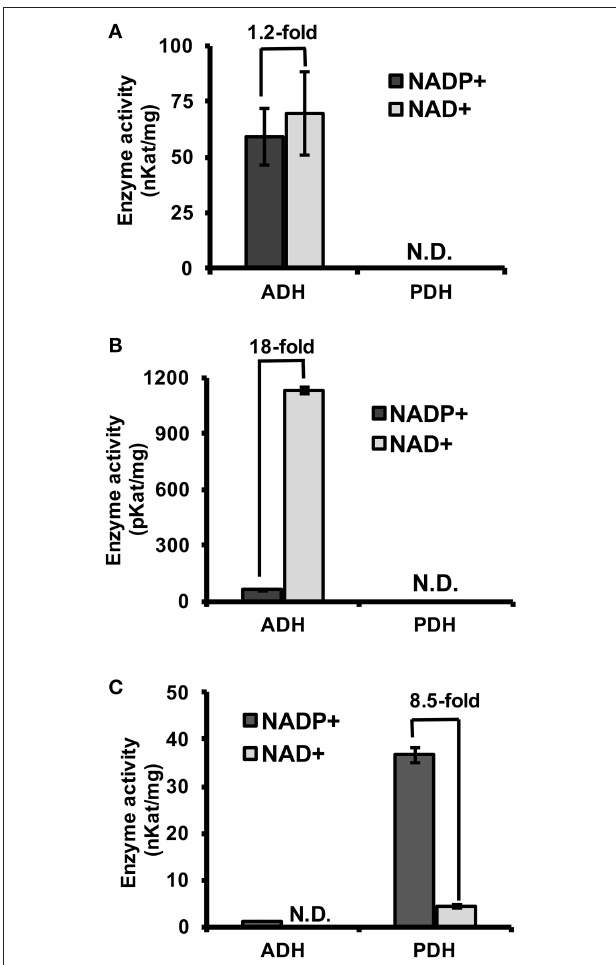
FIGURE 3 | Substrate and cofactor specificity of microbial TyrA orthologs. ADH and PDH assays were performed with 0.8mM arogenate and prephenate, respectively, and 0.8mM cofactor (NADP + , black; NAD + , gray). (A) Purified recombinant SsTyrA (spirochaetes) was used to test enzymatic activity, and shown as the average in nKat/mg protein ± SEM of n = 3. (B) α -proteobacteria TyrA (OiTyrA) cell lysate was used as purification of the recombinant enzyme was not successful. Average enzymatic activity is shown as pKat/mg protein ± SEM of n = 3 (C) Purified recombinant MhTyrA (archaea) was used to test enzymatic activity, and shown as the average in nKat/mg protein ± SEM of n = 3. N.D. no activity detected. Cofactor preference is indicated by the fold-change over the